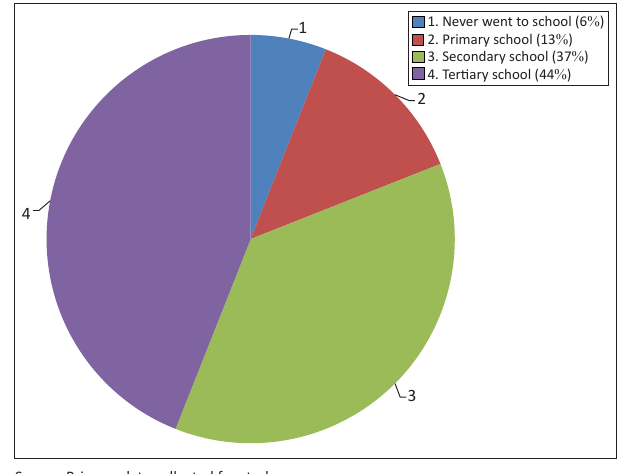
FIGURE 2: Age groups of respondents.